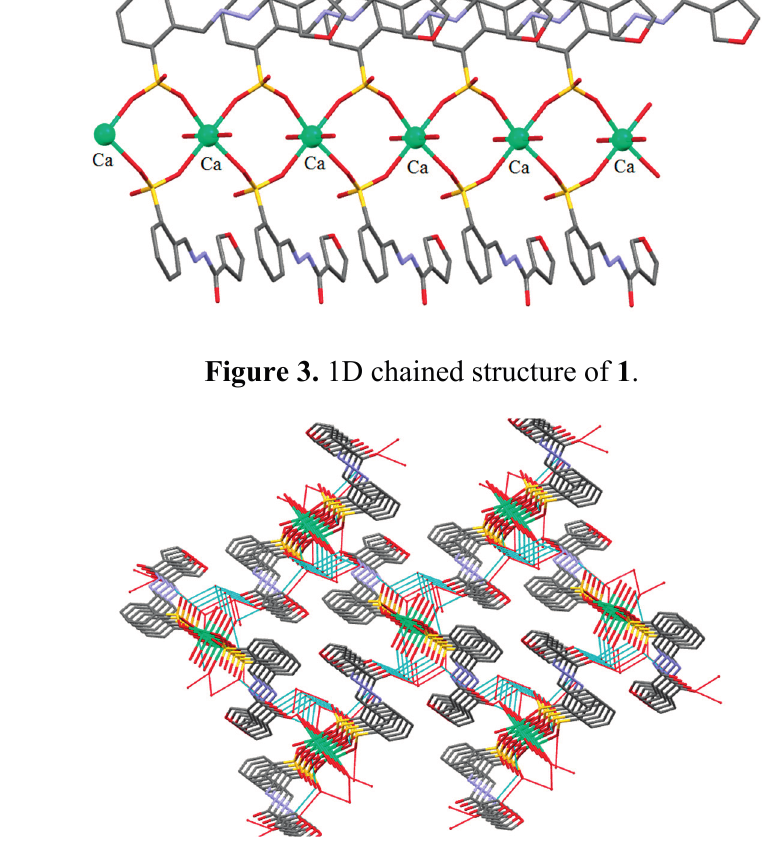
Figure 4. 3D network structure by the interaction of 1D